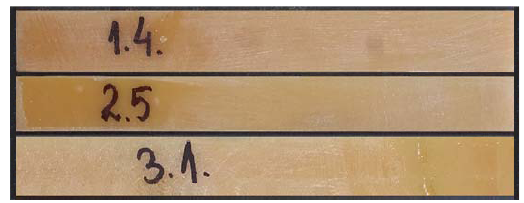
Figure 1. Samples of each set of hybrid